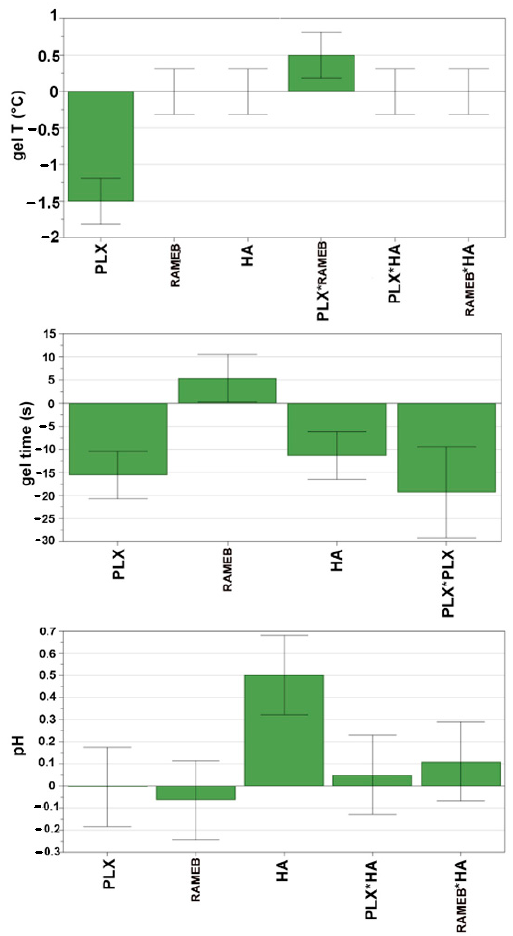
Figure 2. Coefficients plots for gelation temperature, gelation time and pH. Positive and negative bars indicate, respectively, an increment or decrement of the response caused by the term. * is the interaction between the two terms. Non-significant terms have error bars that cross the horizontal axis.